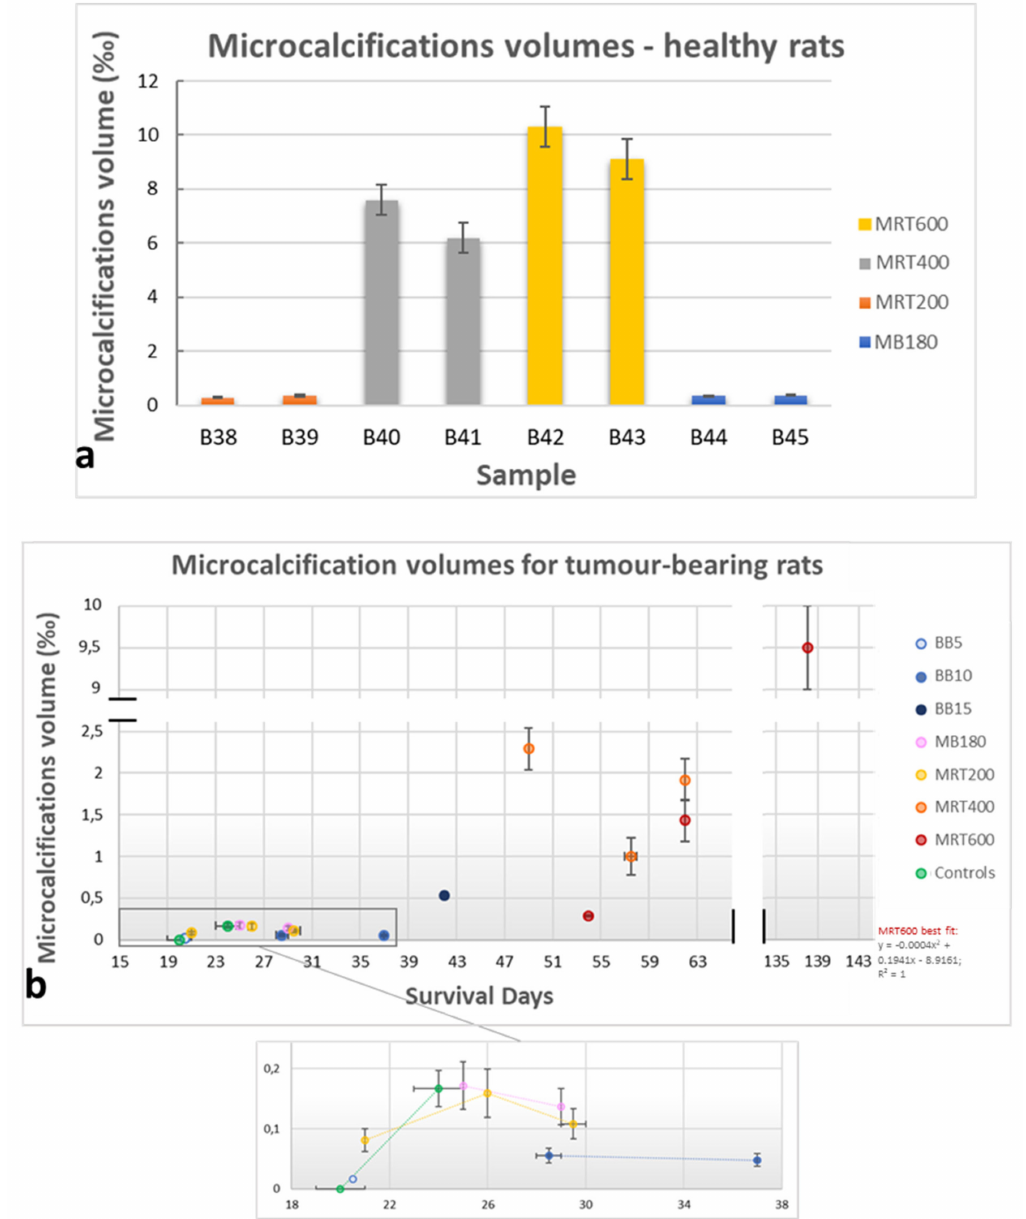
Figure 7. Graphs of the microcalcifications content in healthy irradiated rats sacrificed at D138 ( a ) and in GBM-bearing animals as a function of the survival days ( b ). Values are normalized over the field of irradiation. The zoom in ( b ) better discriminates the values obtained before